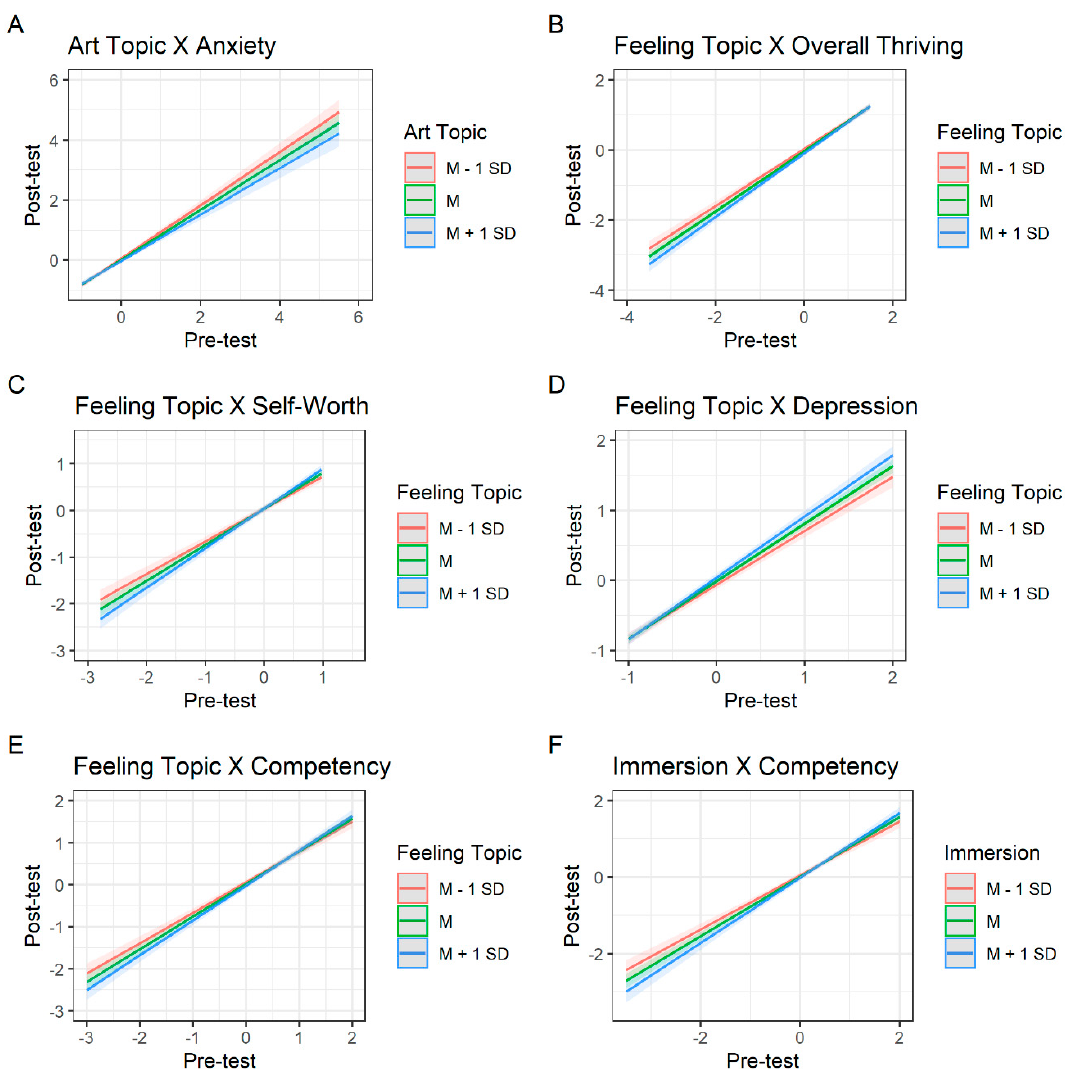
Figure 7. Interactions between pre-test flourishing, immersion, art topics, and feeling topics predicting post-test flourishing.